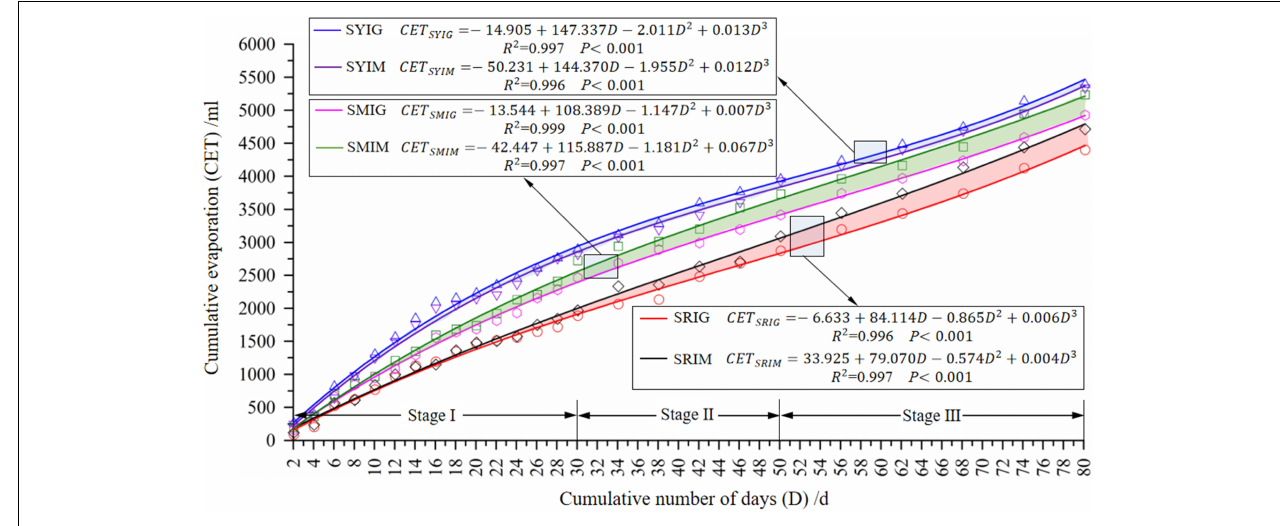
FIGURE 5 | Variation in non-crop soil evaporation with time. Treatment condition codes SRIG, SRIM, SYIG, SYIM, SMIG, and SMIM indicate red soil subjected to root-zone micro-irrigation, red soil subjected to surface-drip irrigation, yellow sand soil subjected to root-zone micro-irrigation, yellow sand soil subjected to surface-drip irrigation, mixed soil subjected to root-zone micro-irrigation, and mixed soil subjected to surface-drip irrigation, respectively.